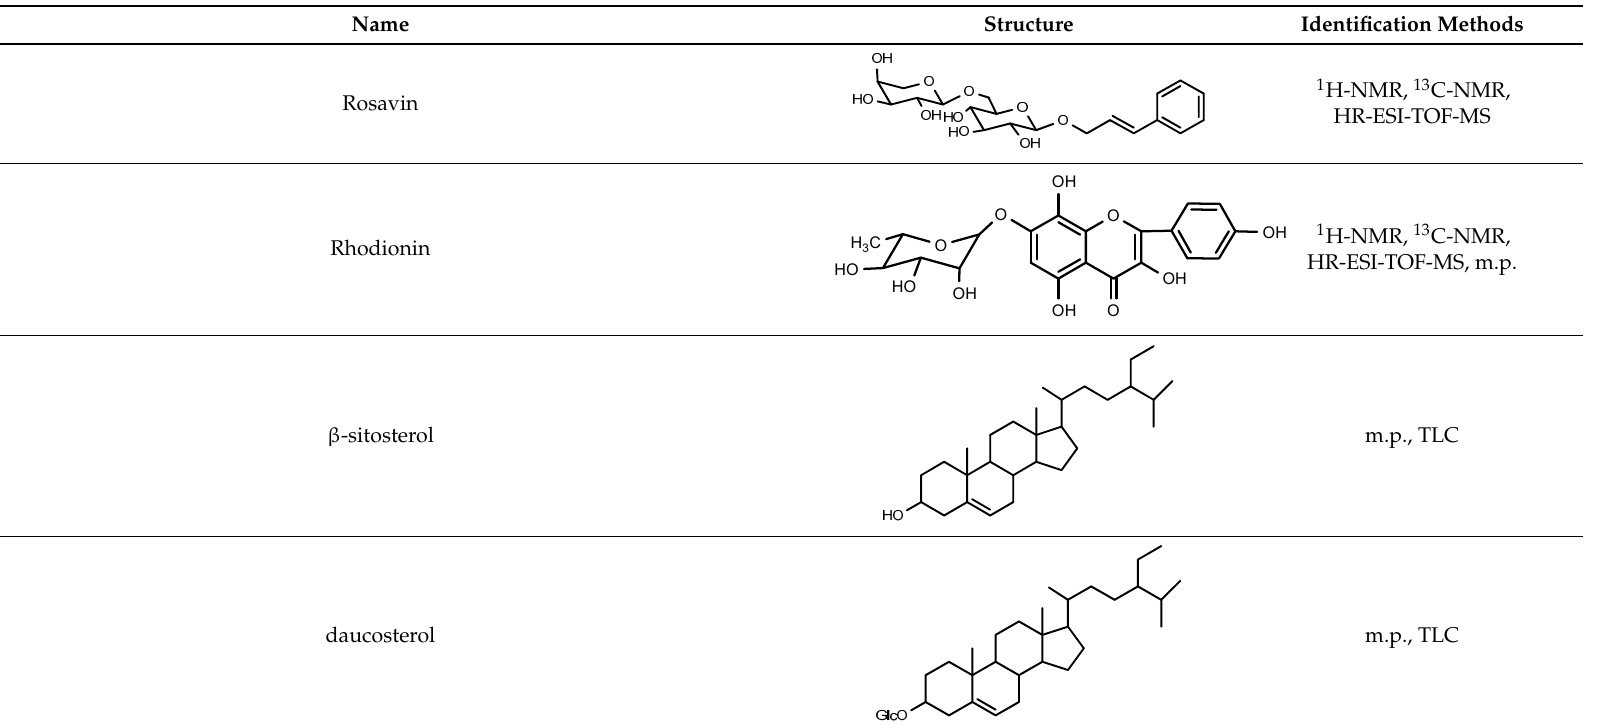
Table 3. The retention time (Rt) and mass (MS) characteristics of the main detected peaks in extracts of Rhodiola rosea L.